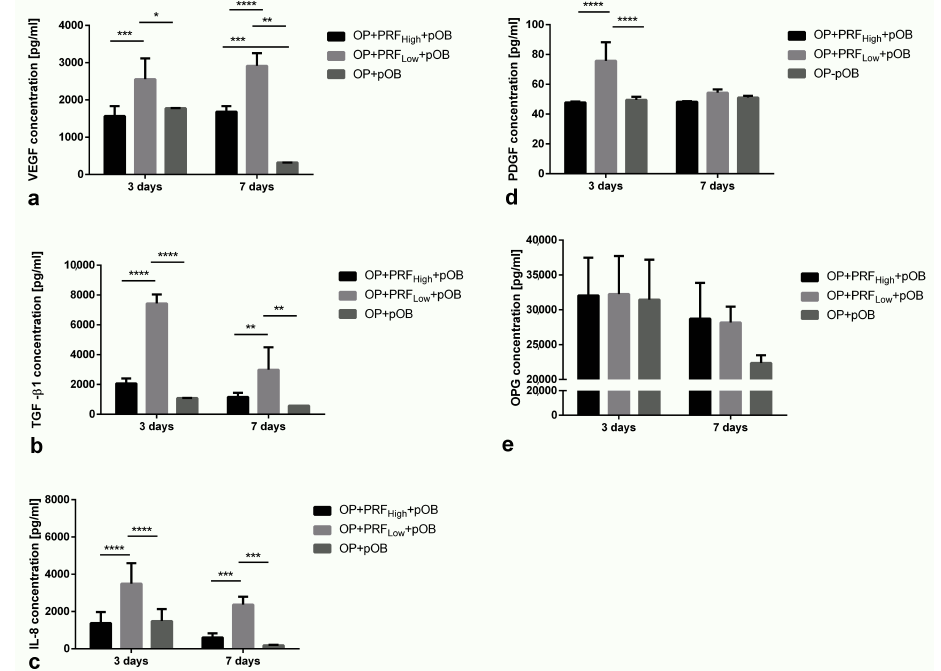
Figure 5. Evaluation of release of the growth factors ( a ) VEGF, ( b ) TGF β 1, ( c ) IL-8, ( d ) PDGF and ( e ) OPG, and in cell culture supernatants of pOBs cultivated on low and high RCF PRF coated Osteopore TM meshes (OP+PRF High +pOB and OP+PRF Low +pOB) and compared to the release of growth factors when pOBs were cultivated on the pure Osteopore TM meshes without PRF precoating (OP+pOB). p -value < 0.05 *, p -value < 0.01 **, p -value < 0.001 *** or p -value < 0.0001